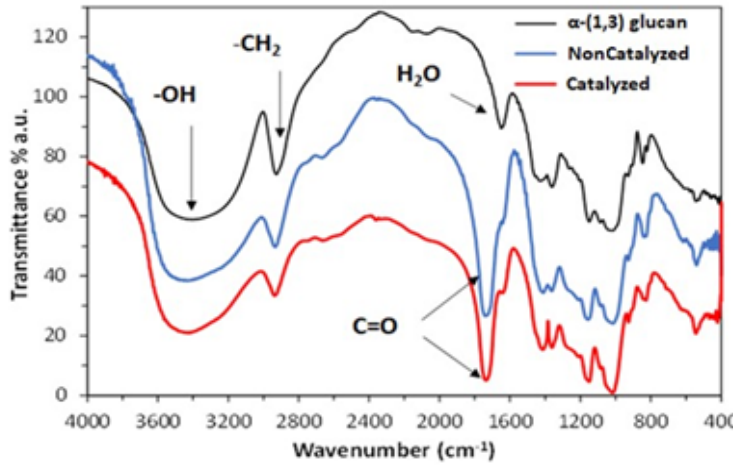
Figure 7. FT-IR spectra of the acylated glucan grades and comparison with the neat grade.